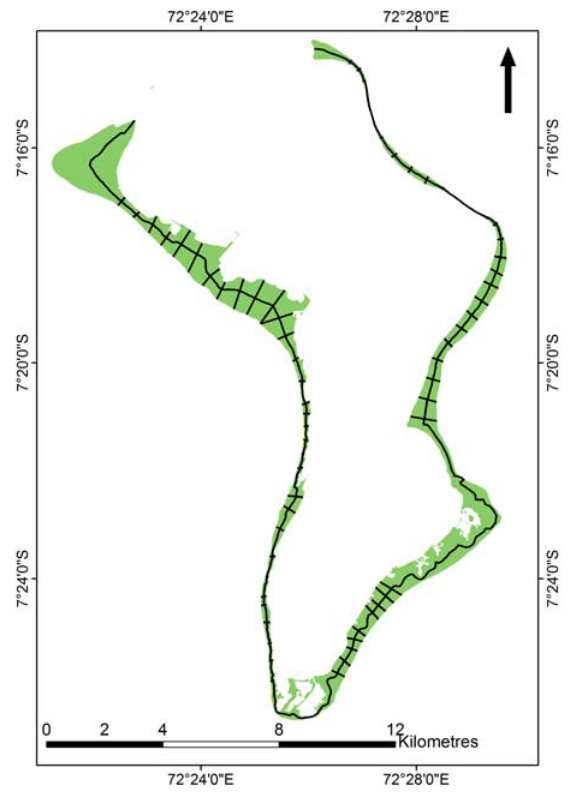
Figure 2. Location of shoreline transects around the Atoll